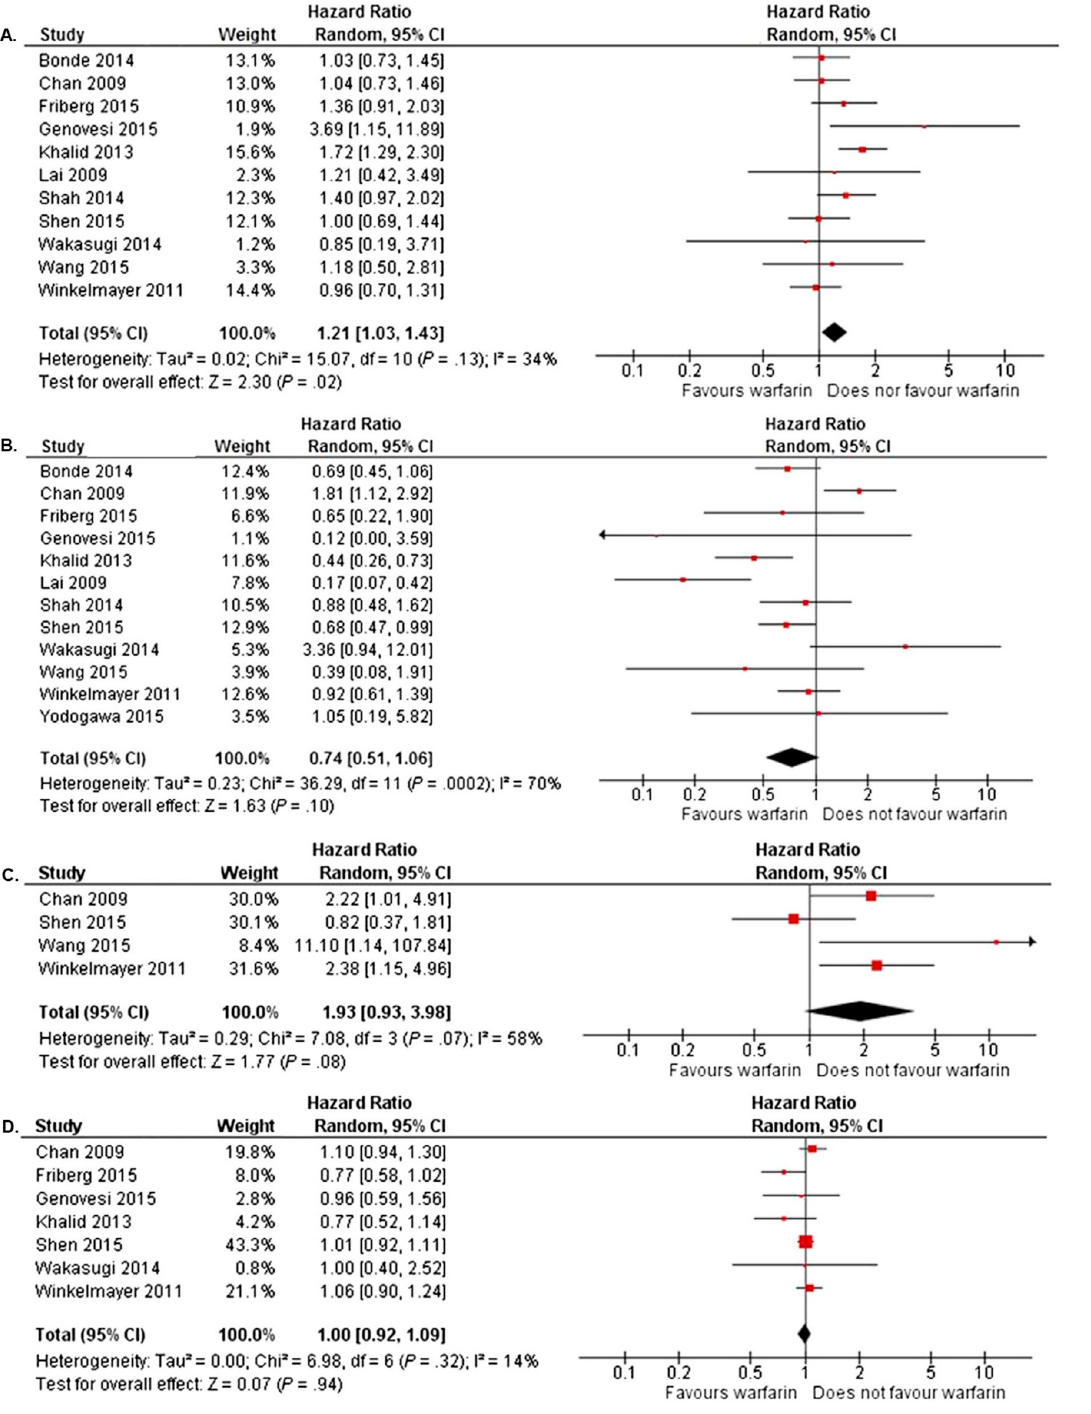
Figure 1. Meta-analysis in patients with end-stage renal disease and atrial fibrillation demonstrating, by forest plots, the risk of four different outcomes associated with warfarin use as compared to no therapy. ( A ) Risk of ischemic stroke. ( B ) Risk of major bleeding. ( C ) Risk of intracranial bleeding. ( D ) Risk of mortality. Reproduced with permission from Van Der Meersch, H.; De Bacquer, D.; De Vriese, A.S., American Heart Journal; published by Elsevier, 2017 [36].